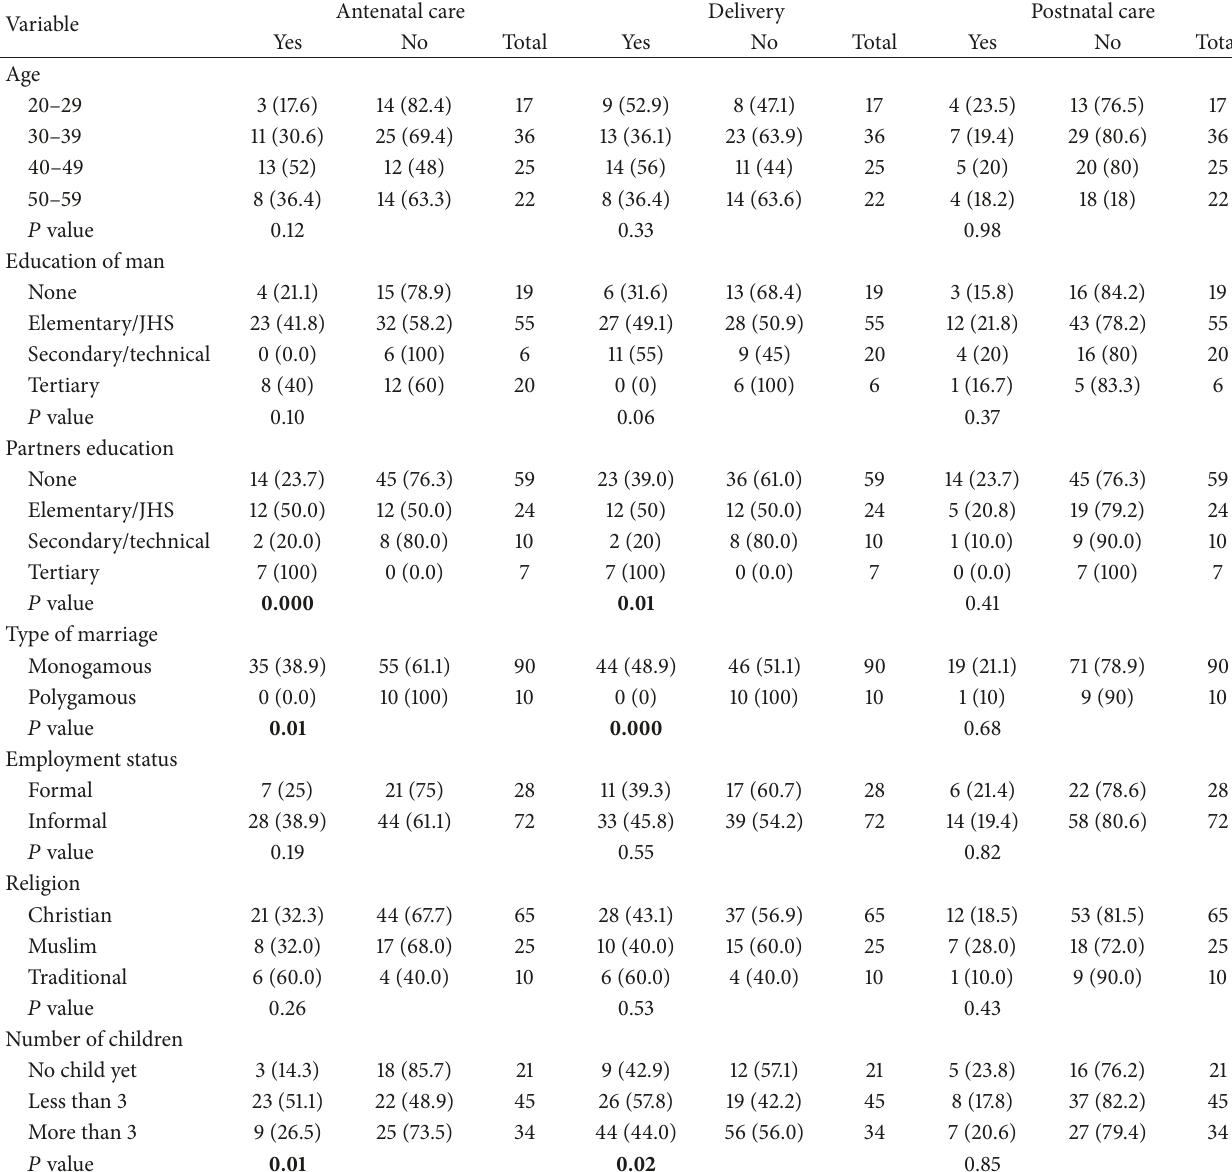
Table 3: Sociodemographic factors associated with male involvement in antenatal care, delivery, and postnatal care ( 𝑁 = 100 ). Variable